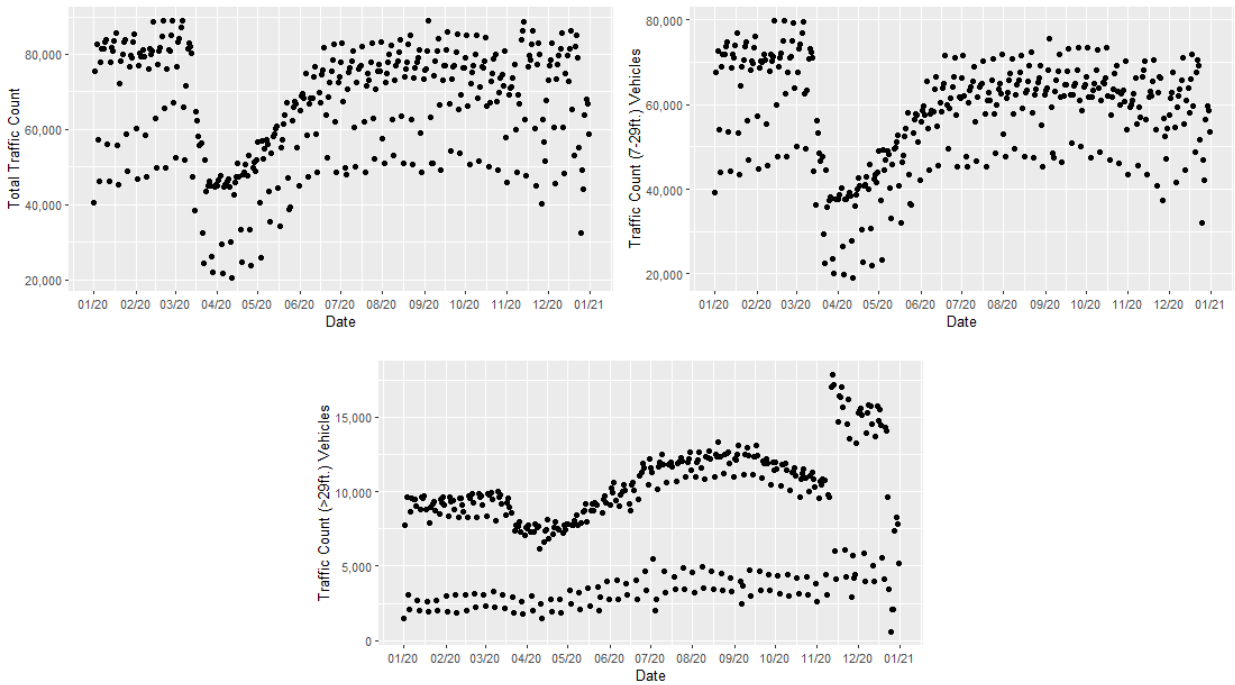
Figure 2. Reported daily average traffic counts at the Northgate site during 2020 for total traffic ( top left ), 7–29 ft ( top right ), and >29 ft ( bottom center ).